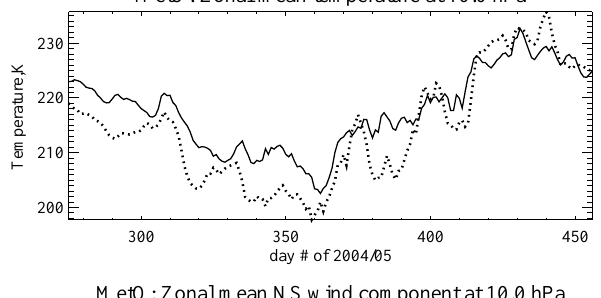
mean temperatures at 60 ◦ N. The meridional component of the wind (middle panel) is weak and directed mostly equator- ward. The zonal component of the wind increases